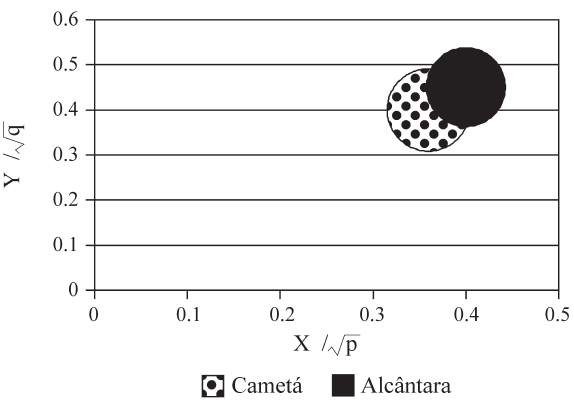
Figure 1 - Comparison of ABO gene frequencies by equivalent circles with 95% probability, in two Brazilian semi-isolated Black communities located in Cametá (PA) and Alcântara